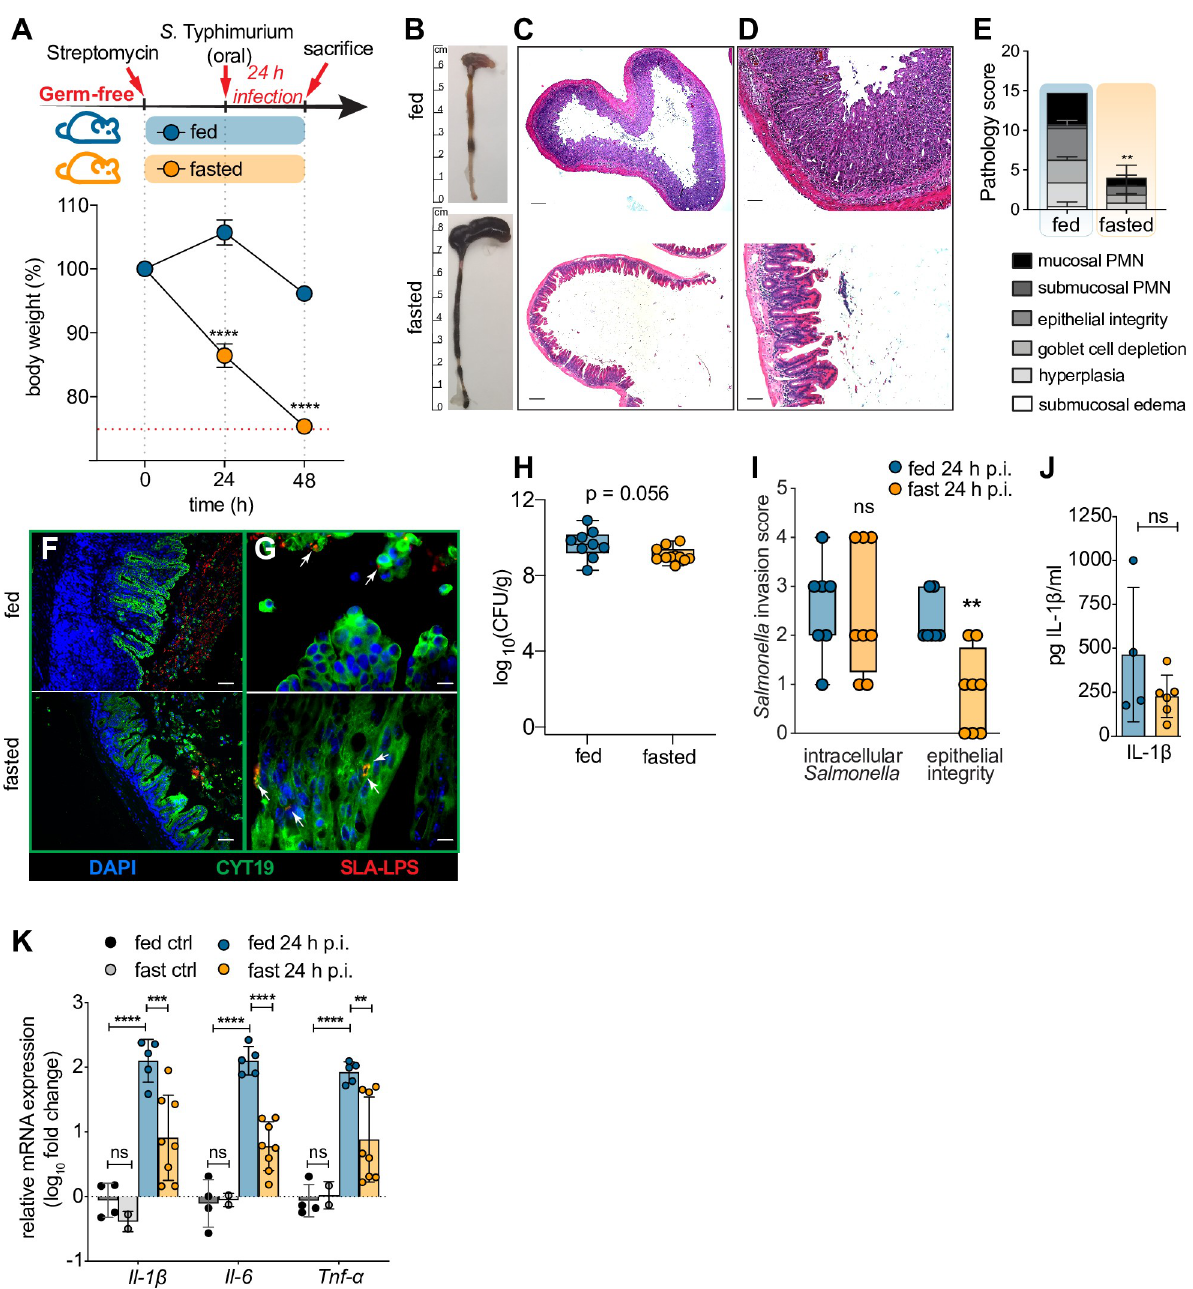
Fig 4. Fasting protects germfree mice from severe gastroenteritis but not from epithelial cell invasion. (A) Experimental timeline of infection and fasting regimen (applicable to all data shown in this figure) and concurrent body weight loss. Streptomycin-pretreated GF C57BL/6 mice were orally gavaged with ~ 2.5 × 10 6 CFU S. Typhimurium and euthanized 24h p.i. (n = 7). (B) Representative macroscopic images of GF mouse cecum and colon pathology 24h p.i. ± 48h of fasting. (C-D) Representative H&E-stained cecal sections of GF mice at 24h p.i. ± 48h of fasting. Scale bar 200 μ m (C), 50 μ m (D). (E) Histopathological analysis of GF mouse cecal H&E tissue sections (see Materials and Methods for scoring criteria). Agreement among raters ensured by Kendall’s coefficient of concordance Wt = 0.737 (n � 7). (F-G) Representative immunofluorescence staining of S . Typhimurium and IEC on GF mouse cecal sections at 24h p.i. ± 48h of fasting. Sections were stained using DAPI to detect DNA (blue), anti- Salmonella -LPS (SLA, red) to visualize S . Typhimurium and anti-cytokeratin 19 (CYT19, green) to stain epithelial cells. White arrows indicate intracellular Salmonella . Scale bar 50 μ m (F), 10 μ m (G). (H) S . Typhimurium CFU per g cecal tissue and stool (combined) 24h p.i. ± 48h of fasting in GF mice. (I) Invasion score quantifying S . Typhimurium presence in IEC by analyzing immunofluorescently stained GF mouse cecal sections at 24h p.i. ± 48h of fasting (shown in F-G) (see Materials and Methods for scoring criteria). Agreement among raters ensured by Kendall’s coefficient of concordance Wt = 0.926 (n � 7). (J) IL-1 β protein levels measured by ELISA in whole cecum lysates of GF mice infected with S . Typhimurium at 24h